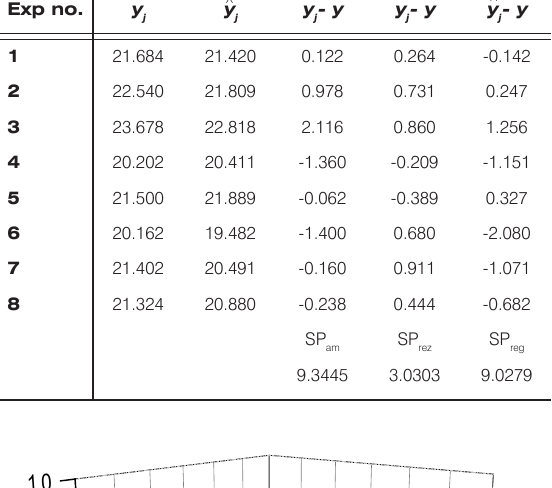
Table 5. Determination of the correlation coefficient, for the model with a 95% level of confidence. Exp no.